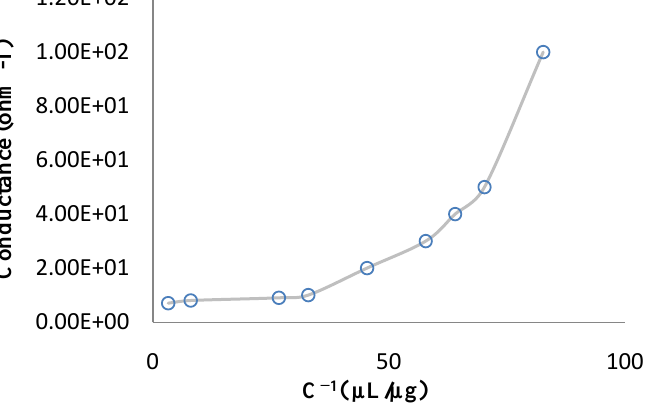
Figure 3. The conductivity versus reverse concentration of DNA strand (C −1 ) in aqueous environment in Au-DNA-Au structure at room